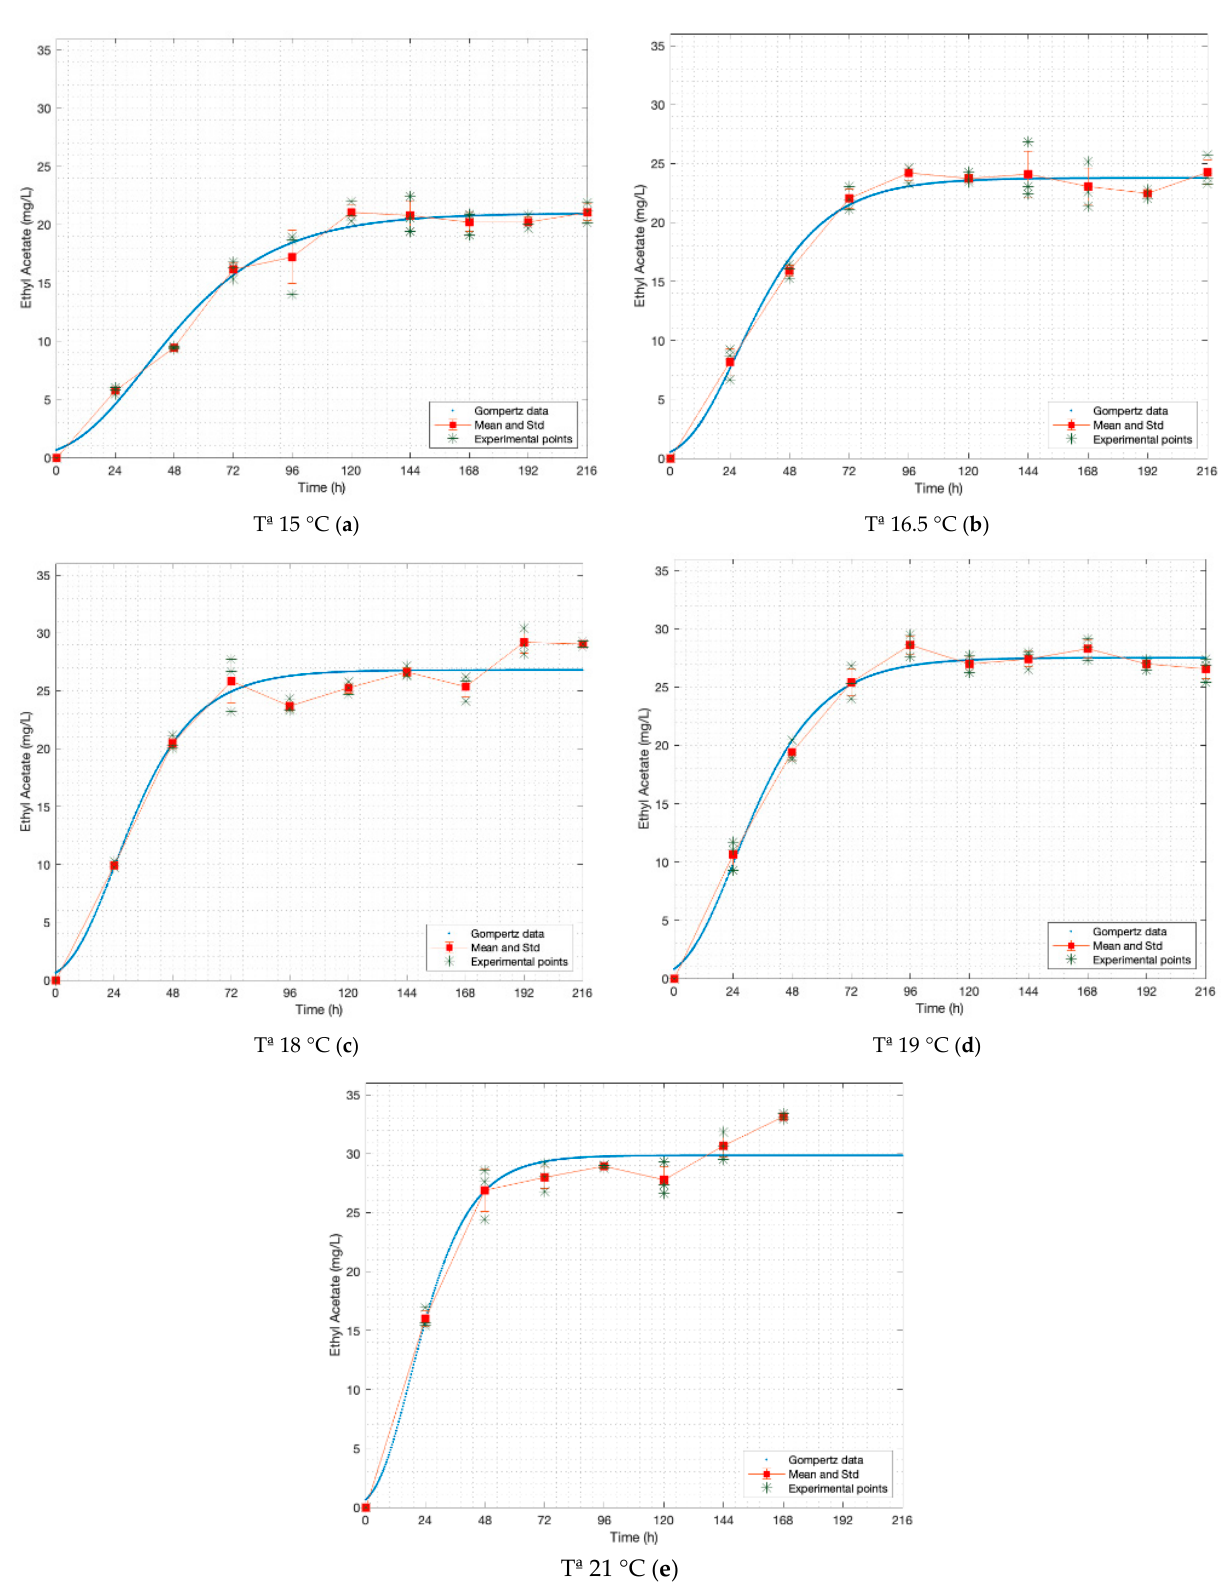
Figure 3. Gompertz graphs of predicted values for ethyl acetate. ( a ) Dataset 15 ◦ C; ( b ) dataset 16.5 ◦ C; ( c ) dataset 18 ◦ C; ( d ) dataset 19 ◦ C; ( e ) dataset 21 ◦ C. Blue lines represent the Gompertz function. Asterisk represents experimental raw data. Squares and red lines represent the means and standard